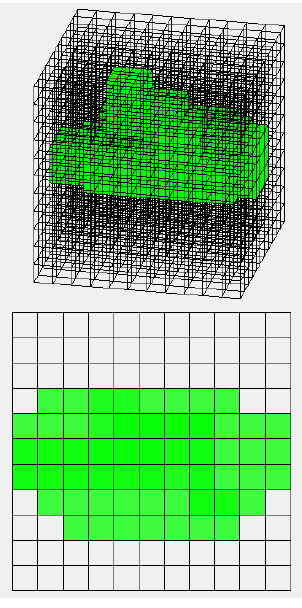
Figure 10. The oblique voxel representation (upper image) and the top view (lower image) of the XYZ buffer in the first test case.